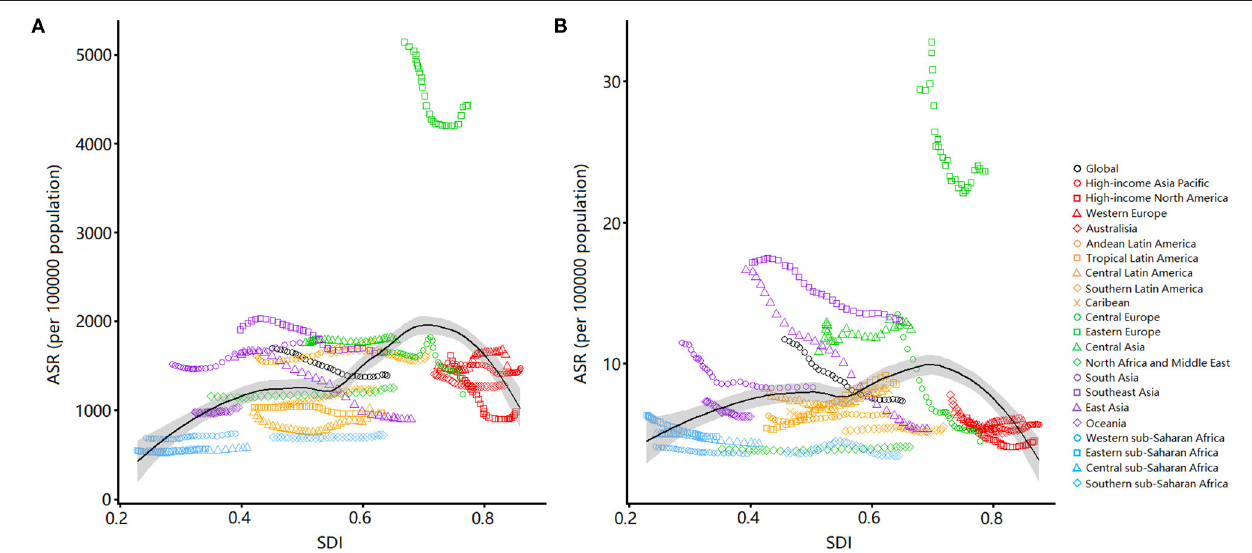
FIGURE 5 | Age-standardized rates of incidence (A) and DALYs (B) for urolithiasis by SDI, 1990–2019, and expected value-based SDI. Age-standardized rates are plotted for 21 geographic regions between 1990 and 2019 against their SDIs. Points in each line from left to right represents the values from 1990 to 2019. The black line represents the average expected relationship between SDI and incidence (A) or DALYs (B) for urolithiasis based on values from all countries over the 1990–2019 estimation period. DALYs, disability-adjusted life years; SDI, sociodemographic